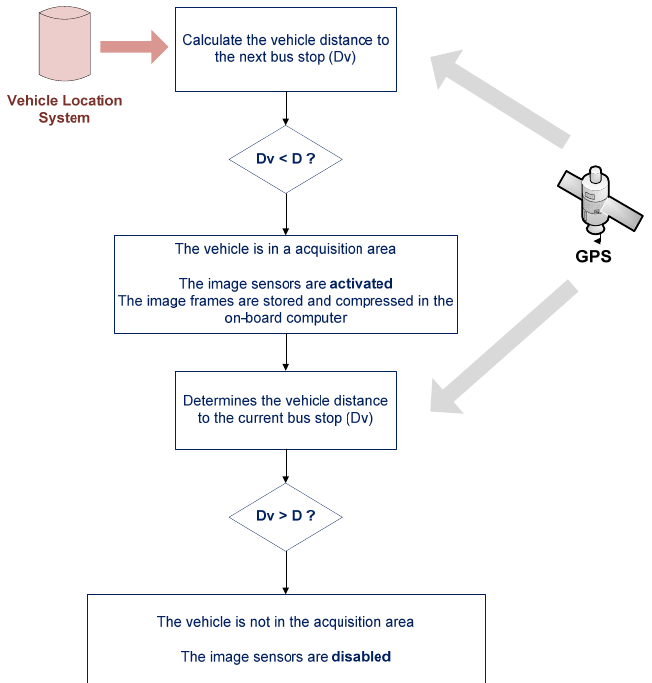
Figure 8. External vehicle sensors.